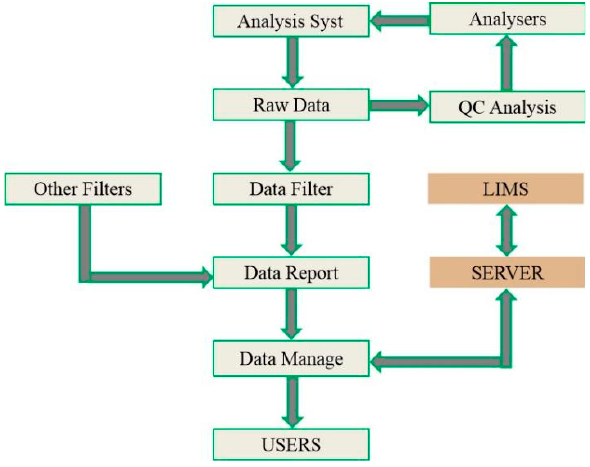
Figure 1. Overall structure of the system.